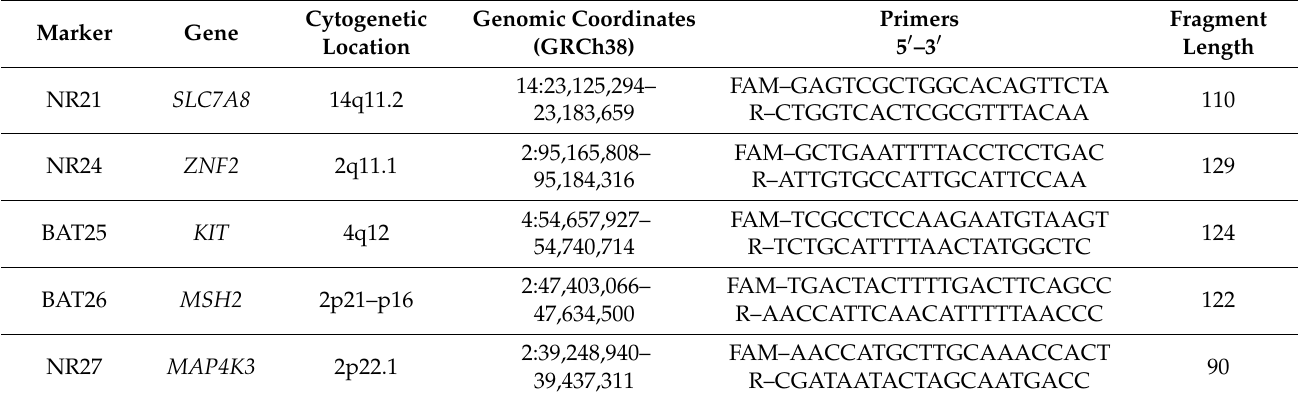
Table 5. Characteristics of markers used for fragment